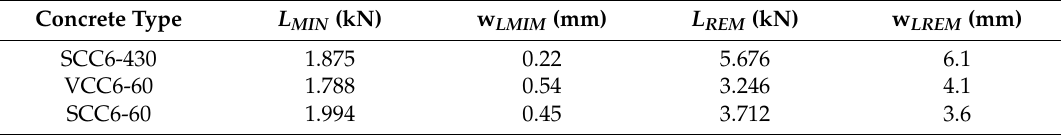
Table 3. Minimum ( L MIN ) and maximum ( L REM ) post-cracking loads and their corresponding crack openings (w LMIM for L MIN), and w LREM for L REM ).